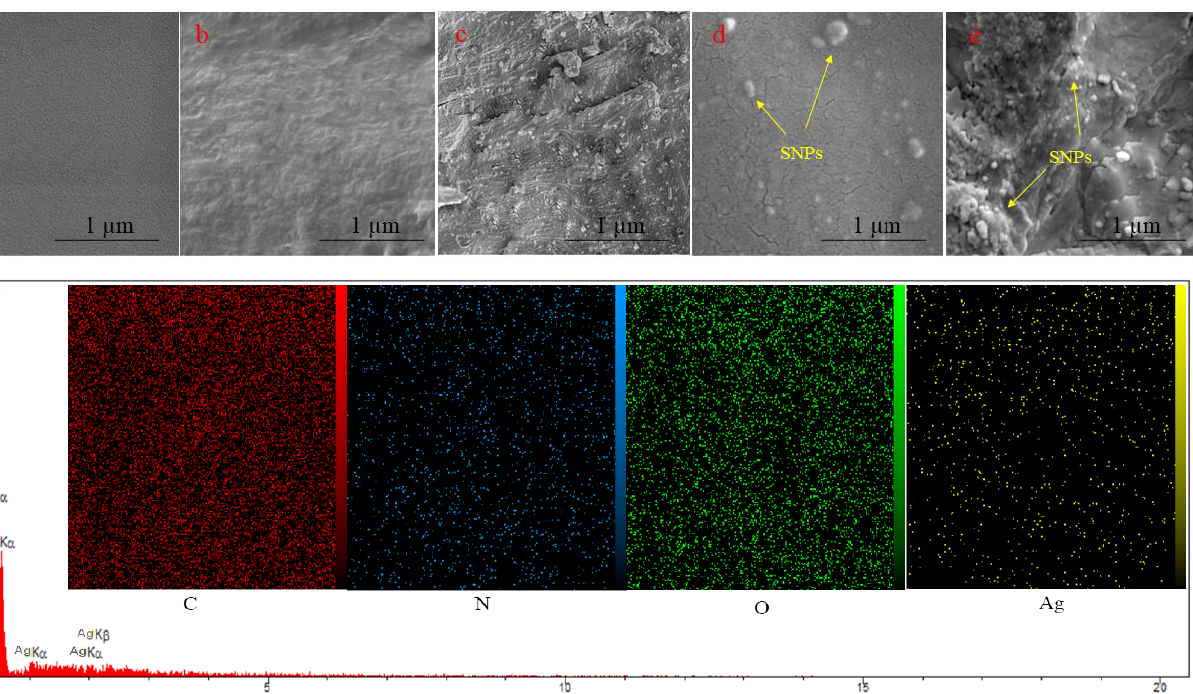
Figure 1. Appearance of SPI-based films containing persian gum (PG) and silver nanoparticles (SNPs).